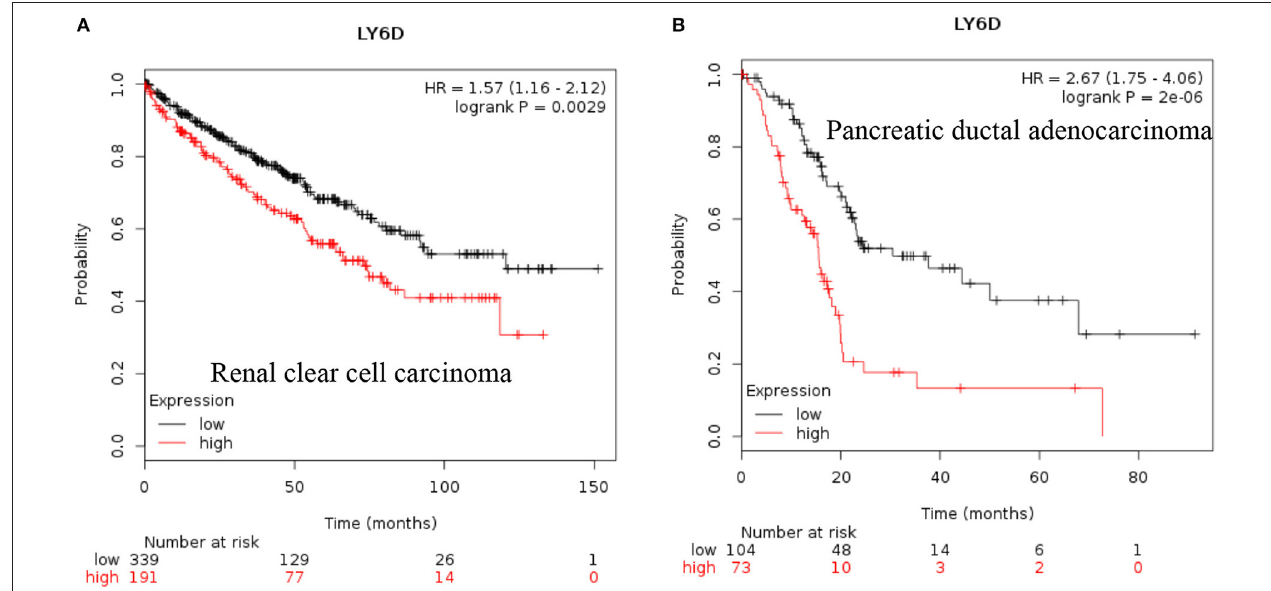
FIGURE 1 | Increased LY6D mRNA expression in cancer and patient survival. High LY6D RNA expression leads to poor survival in (A) renal clear cell carcinoma, (B) pancreatic ductal adenocarcinoma. These data were recently added in Km plotter webtool from RNA seq pan cancer analysis (38).